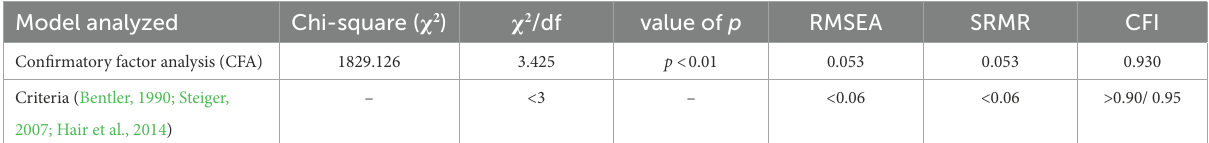
TABLE 3 Degree of model fit for